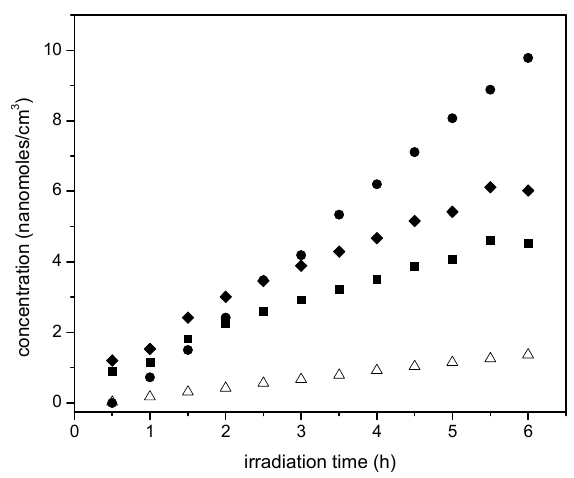
Figure 16. CO 2 increase with irradiation time for: ( ● ) 2.50 wt. % Pt–TiO 2 (sol-gel B), ( ■ ) 1.70 wt. % Pt– Pt–TiO 2 (sol-gel A), ( (cid:7) ) 1.70 wt % Pt–TiO 2 (wetness impregnation) and ( ∆ ) Degussa P25. Standard TiO 2 (sol-gel A), ( ♦ ) 1.70 wt. % Pt–TiO 2 (wetness impregnation) and ( ∆ ) Degussa P25. Standard deviation for repeats is within ± 5%. deviation for repeats is within ±5%.